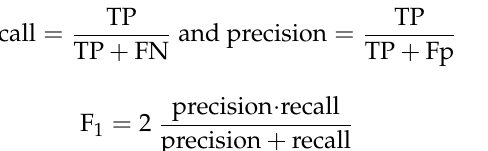
Table 3. Selected number of clusters for different matrices and cities.